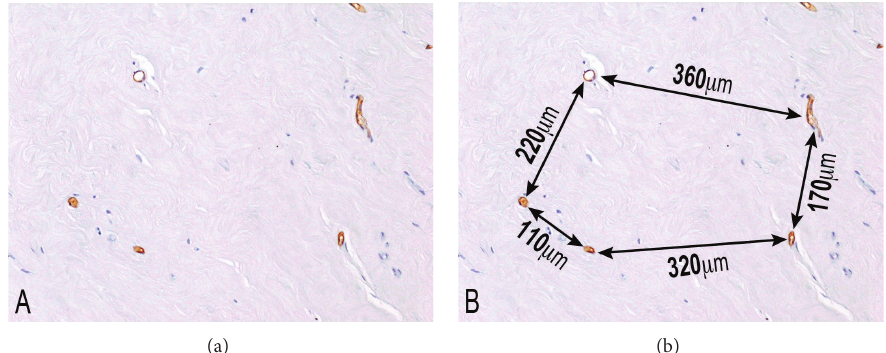
Figure 5: Phase 4 Fibroid. Hyalinized areas of fibroids, as in this phase 4 tumor, sometimes exhibit prominently reduced vascularity, in comparison to the adjacent areas of residual smooth muscle. Factor 8 immunostaining highlights the widely separated vessels in (a), and the distance between these vessels, measured with an ocular micrometer, is shown in (b). Note that the distances between adjacent vessels range from 110 𝜇 m to 360 𝜇 m, often exceeding the physiologic limits of cell survival, as evidenced by almost a total absence of cellularity within the intervening stroma. 10x original objective magnification.